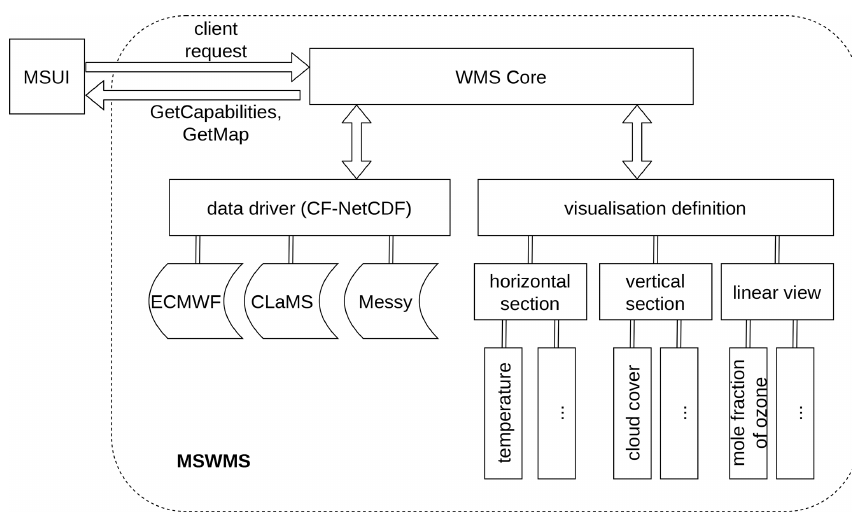
Figure 2. Data driver and visualisation definitions for the MSWMS server.